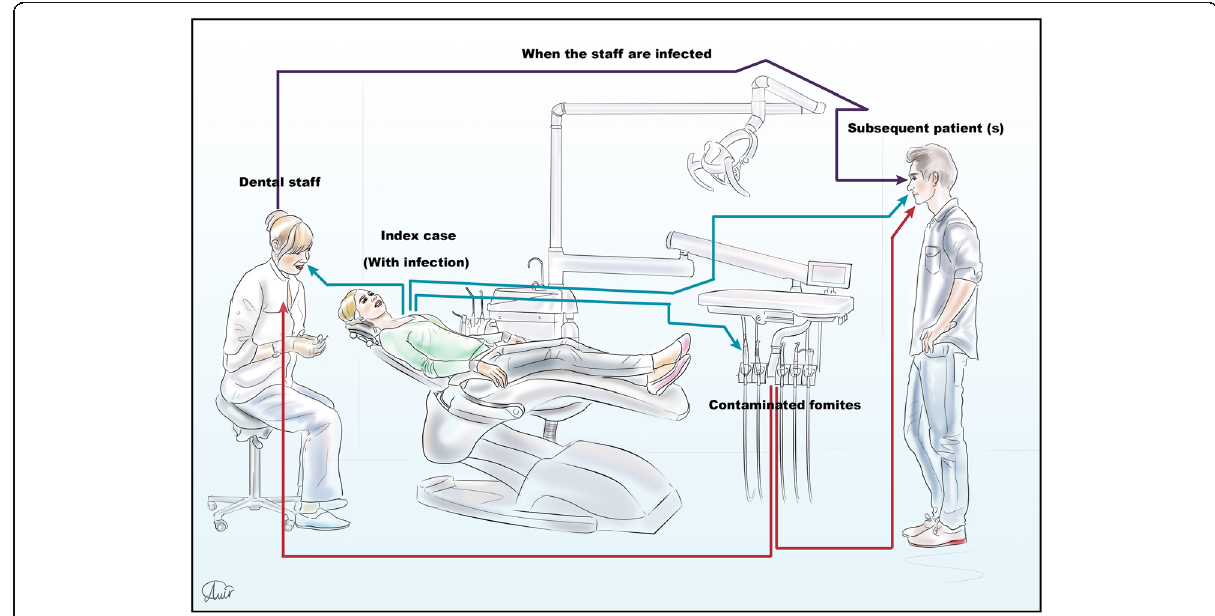
Fig. 4 2019-nCoV transmission dynamics in dental care